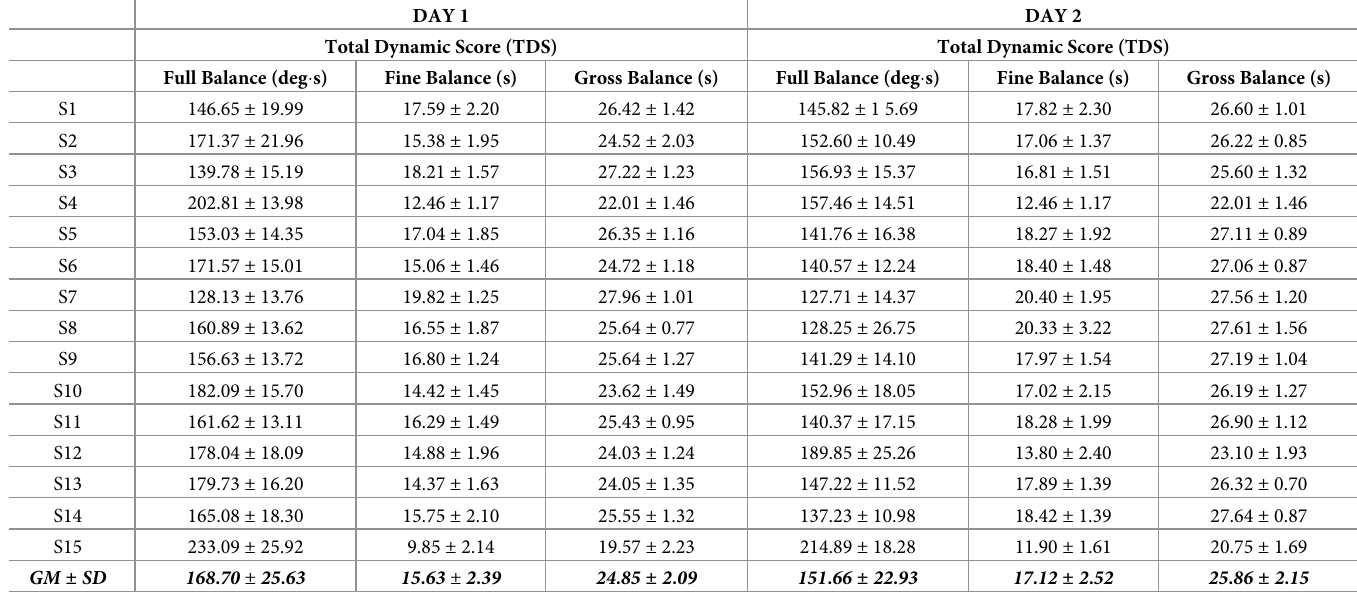
Table 3. Mean values, group means (GM), and standard deviations (SDs) of the kinematic parameters (Full balance, Fine Balance, and Gross Balance) during the unstable board test (DAY 1) and retest (DAY 2) performances. The Total Dynamic Score (TDS) was calculated for each subject averaging the ten AP and ML trials.